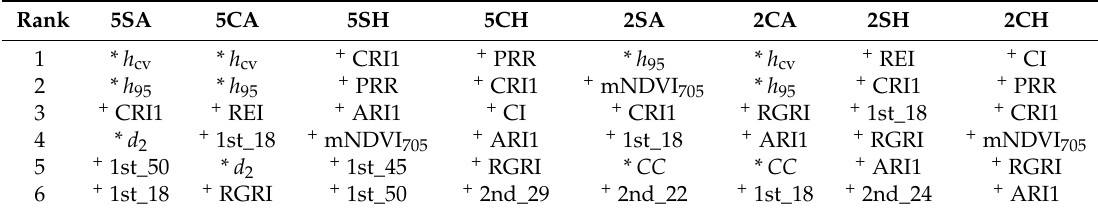
5SA = Five tree-species classification using all metrics (LiDAR and sunlit hyperspectral metrics); 5CA = Five tree-species classification using all metrics (LiDAR and crown hyperspectral metrics); 5SH = Five tree-species classification using sunlit hyperspectral metrics; 5CH = Five tree-species classification using crown hyperspectral metrics; 2SA = Two forest-types classification using all metrics (LiDAR and sunlit hyperspectral metrics); 2CA = Two forest-types classification using all metrics (LiDAR and crown hyperspectral metrics); 2SH = Two forest-types classification using sunlit hyperspectral metrics; 2CH = Two forest-types classification using crown hyperspectral metrics; * = LiDAR metrics; + = Hyperspectral metrics.